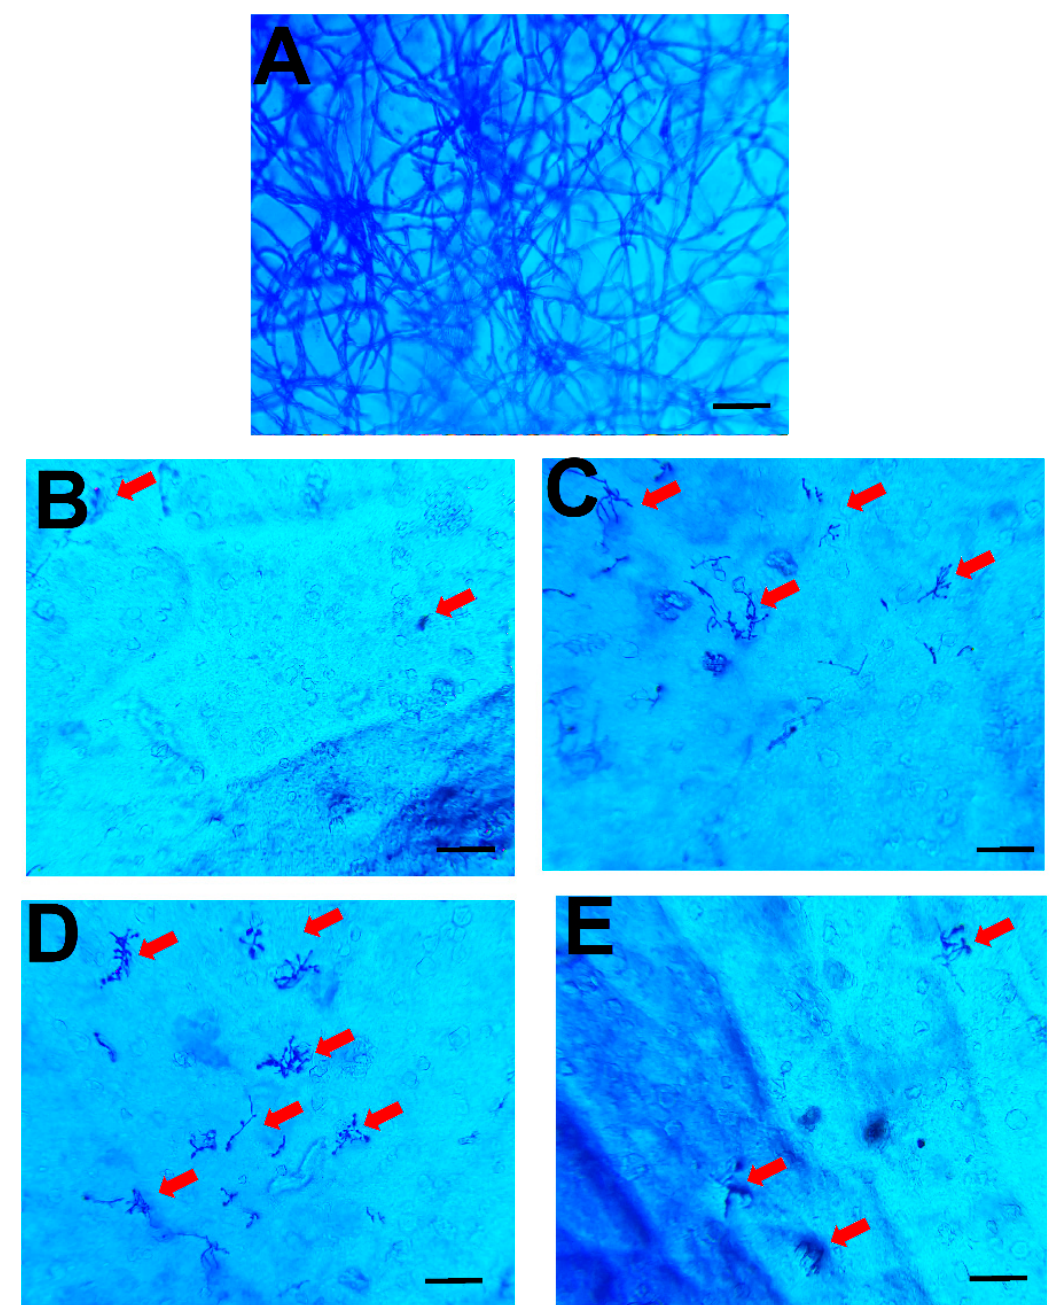
Figure 2. Germination of conidia from F. temperatum obtained by the agar microdilution method performed in soft lens. The emergence of mycelium in sole PDA ( A ) demonstrated the viability of conidia whereas PDA containing 120 mg L − 1 ZlEO ( B ), 150 mg L − 1 2-undecanone ( C ), 220 mg L − 1 2-undecenal ( D ) and 130 mg L − 1 2-dodecenal ( E ) exerted a clear inhibition on the conidial germination and mycelial proliferation of F. temperatum . Red arrows indicate insights of conidial germination and the black scale bar is equivalent to 50 µm.